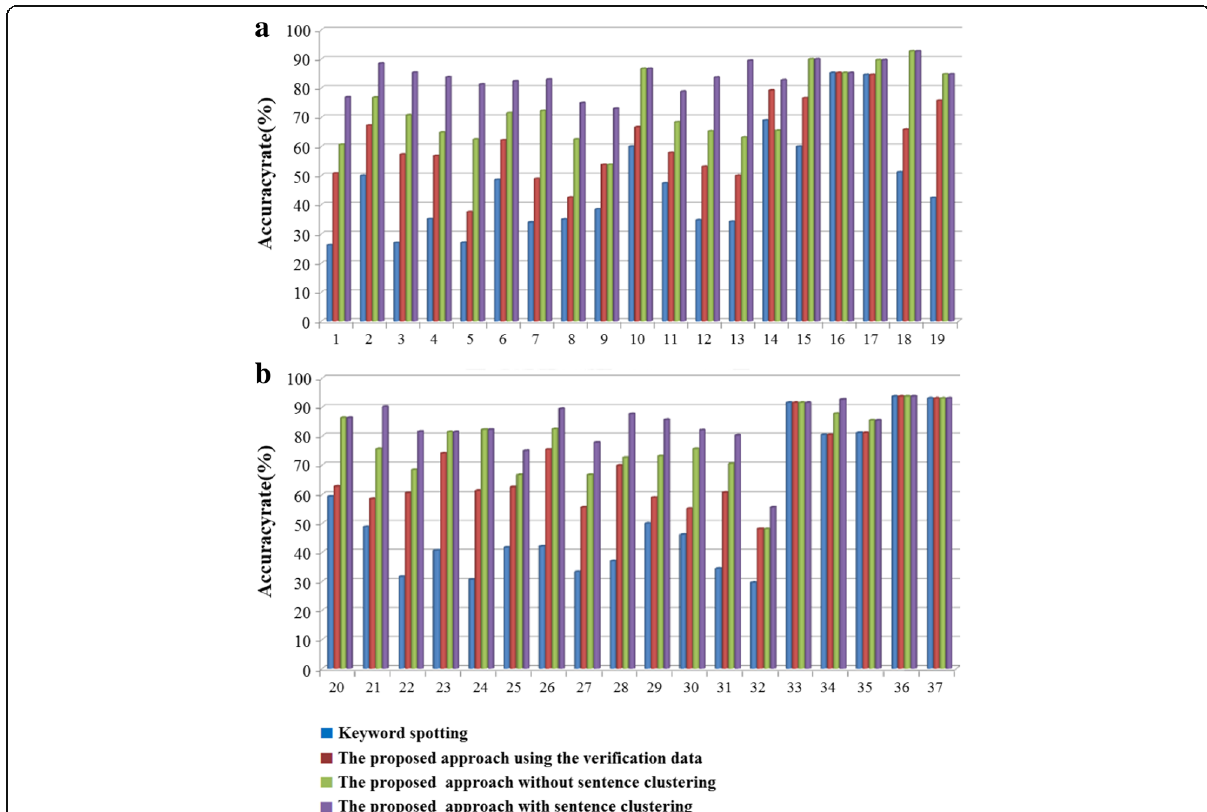
Fig. 11 Detection performance for each individual DS. a DS 1~19 and b DS 20~37 using (1) keyword spotting, (2) the proposed approach using the verification data, and the proposed approach (3) without/(4) with sentence